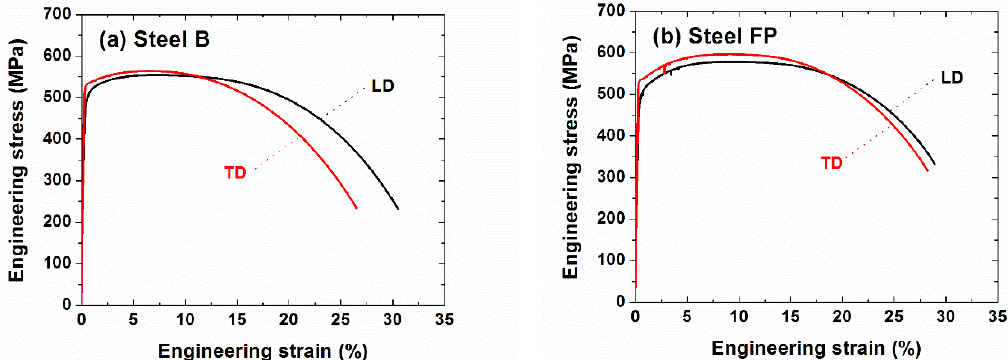
Figure 8. Representative engineering stress-strain curves of as-received pipe state for ( a ) steel B and ( b ) steel FP, tensile tested along both longitudinal direction (LD) and transverse direction (TD).